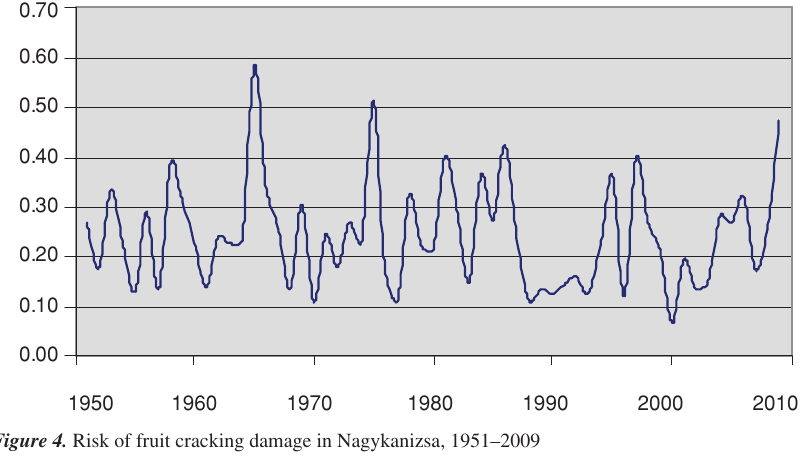
Figure 4. Risk of fruit cracking damage in Nagykanizsa, 1951–2009